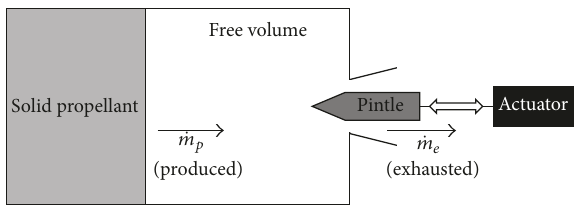
Figure 1: Variable thrust solid propulsion system (VTSPS) with a pintle